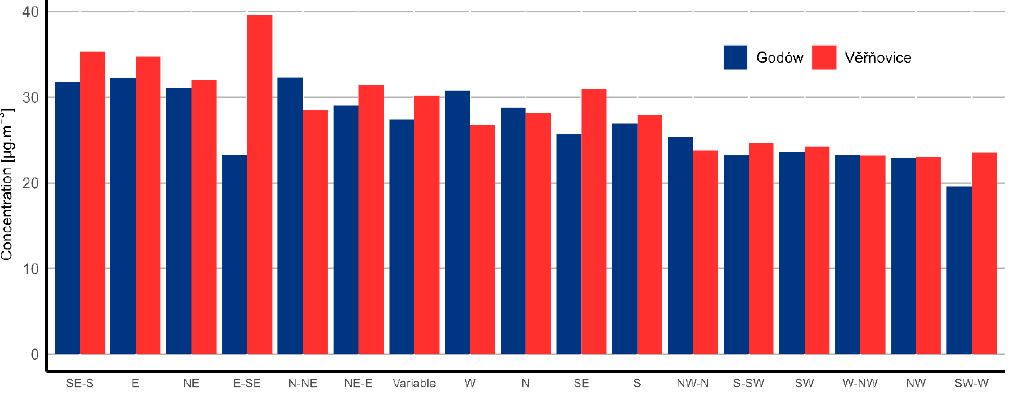
Figure 10. Average PM 10 concentrations for individual daily wind types, V ěřň ovice and Godów site, warm seasons (I–IX) 2011–2020.